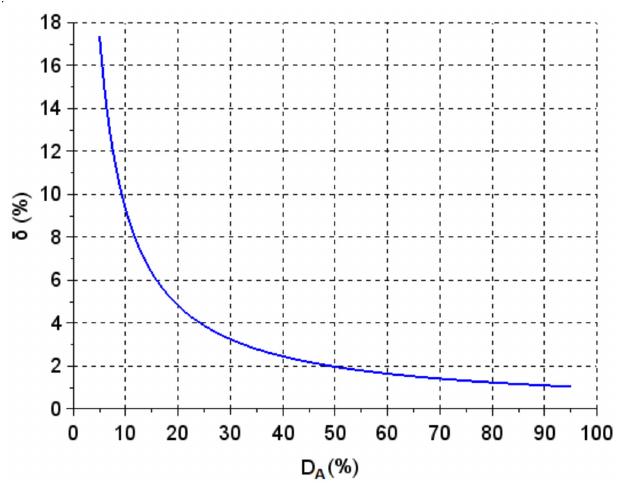
Figure A8. Influence of 0.5% deviation in the duty cycle on the input resistance calculations of a buck